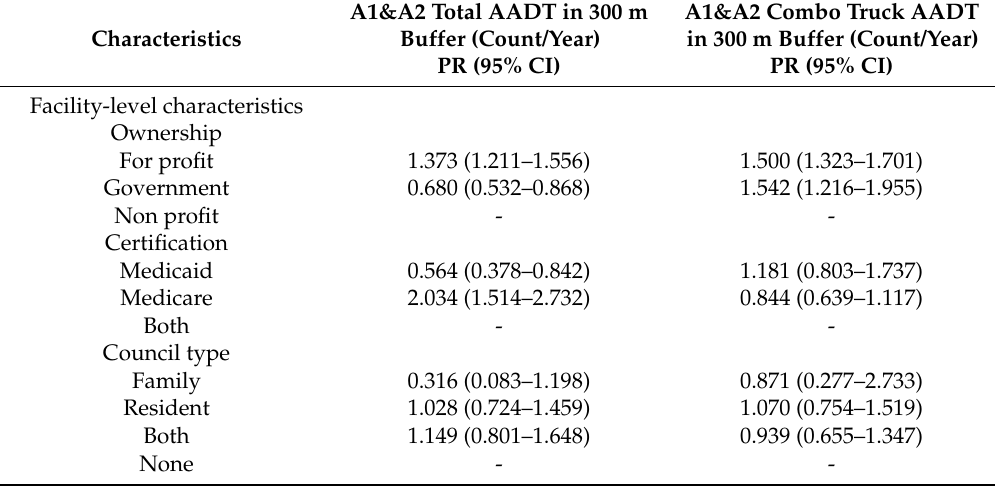
Table 3. Prevalence ratios of facility- and census-tract-level characteristics associated with high/low traffic density (total AADT), and high/low traffic density (combo truck AADT) of major roadways within 300 m buffer